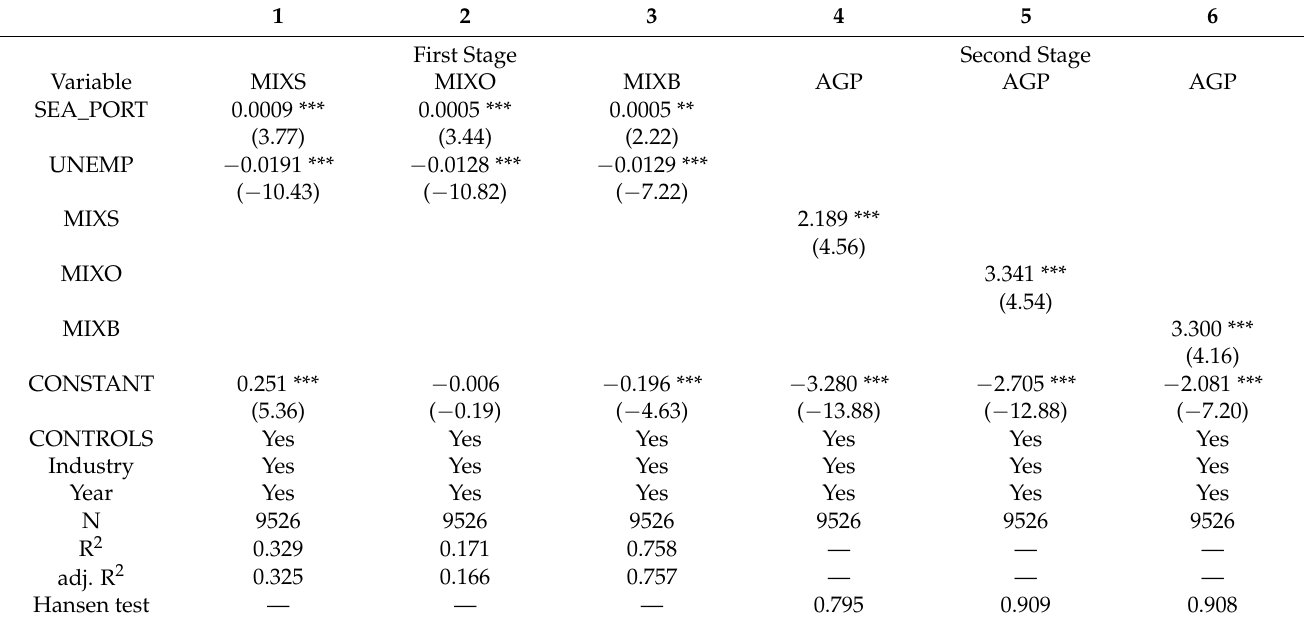
Table 5. The two-stage